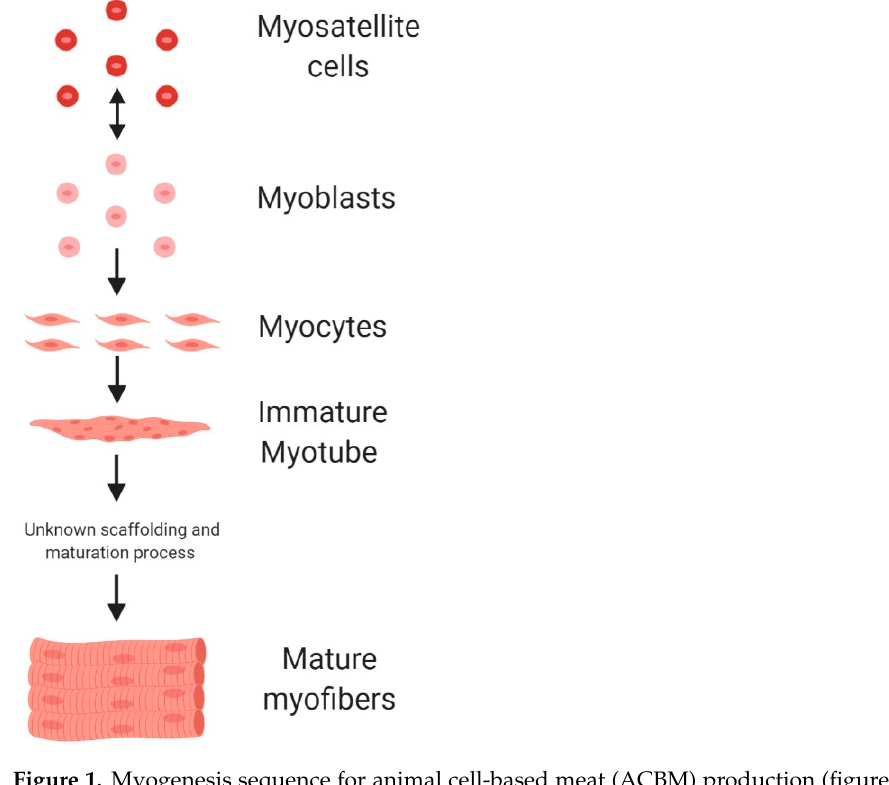
Figure 1. Myogenesis sequence for animal cell-based meat (ACBM) production (figure produced using BioRender).